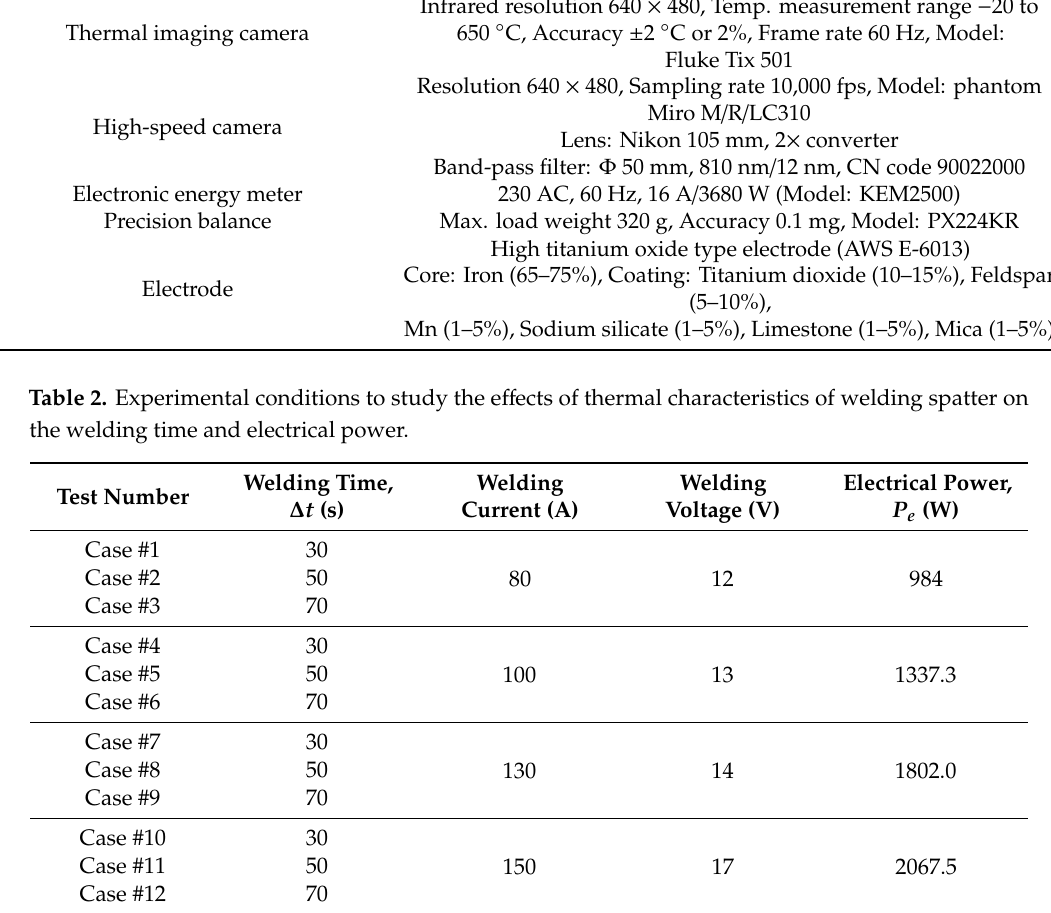
Welding polarity: DC-, Contact angle: 90°, Arc length: 5 mm, Base metal: Mild steel (SS400); Electrode diameter, d el : 4.0 mm, Material properties of electrode given in Table 1.